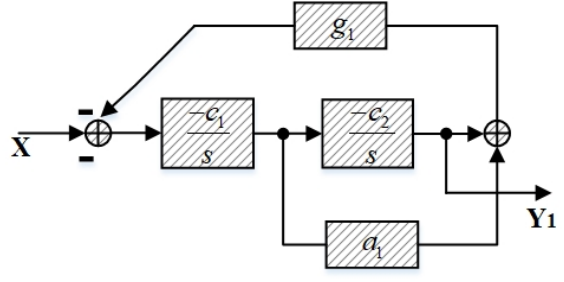
Figure 4. Architecture of the loop filter in the signal observation.